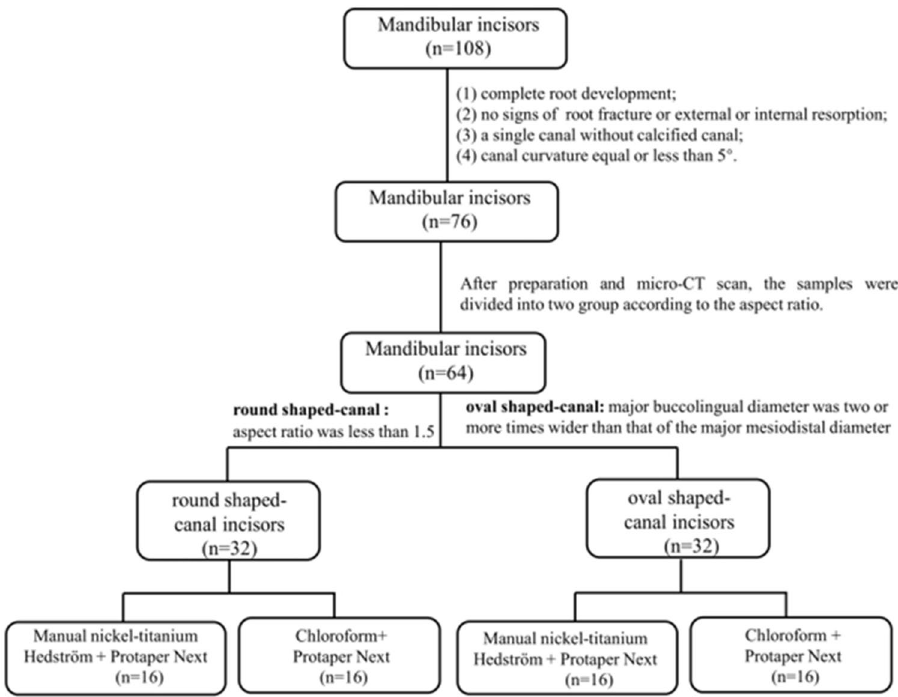
Figure 1. Sample screening and grouping flow